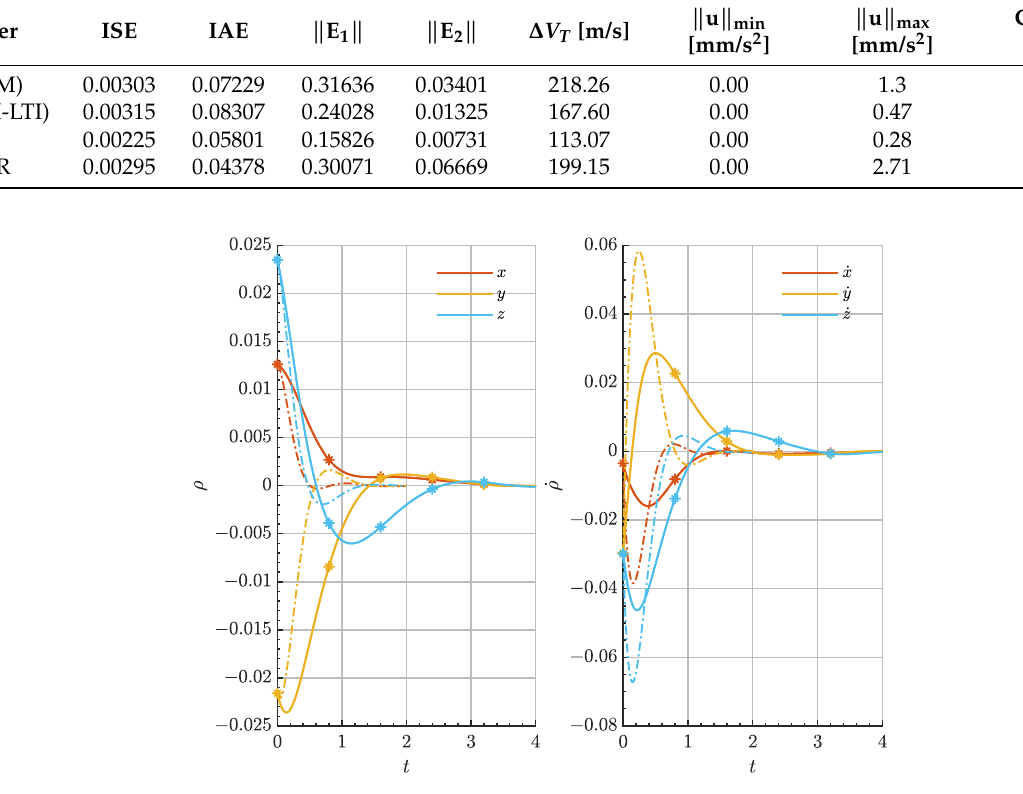
Figure 10. Relative state evolution for the SDRE (*) and AL-iLQR (dashed) controllers for the halo transfer mission scenario.